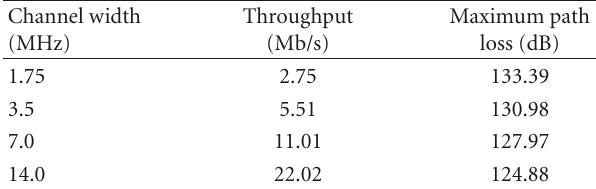
Table 9: Throughput and path loss for di ff erent channel sizes. Channel width